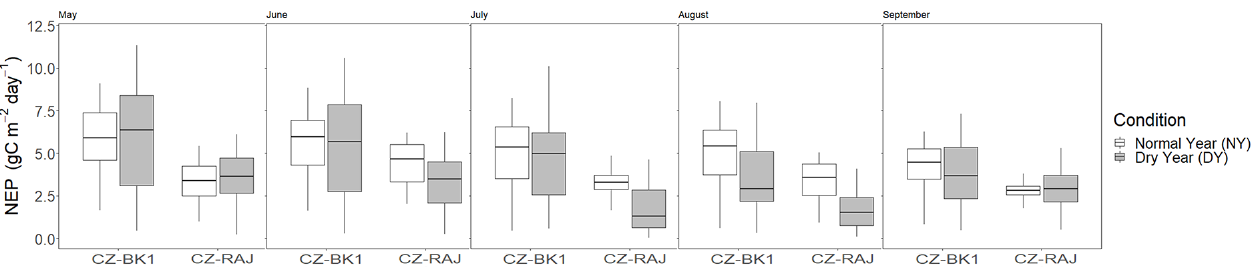
Figure 7. Monthly averages of daily sums of NEP for May–September of the normal years (NY) and dry year (DY) in CZ-BK1 and